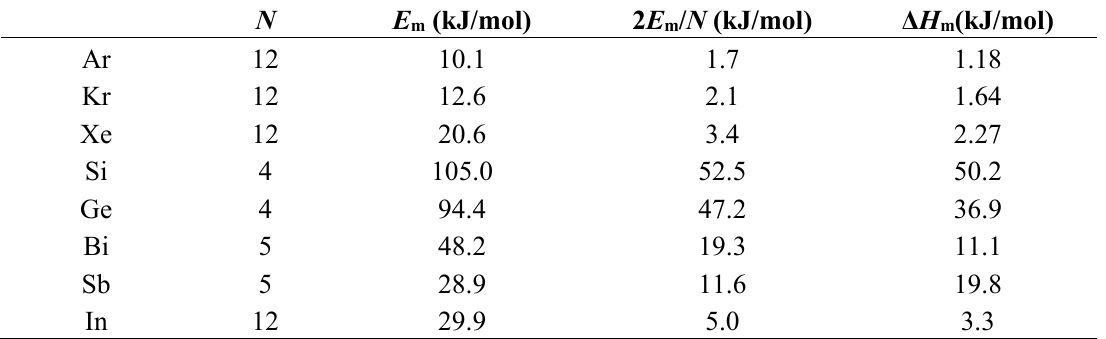
Table 1. The activation energy of vacancy migration E m [30], the number of the first coordinating atoms in crystals N [31], the accordingly calculated latent heat of melting 2 E m / N [29], and the measured latent heat of melting Δ H m [28].